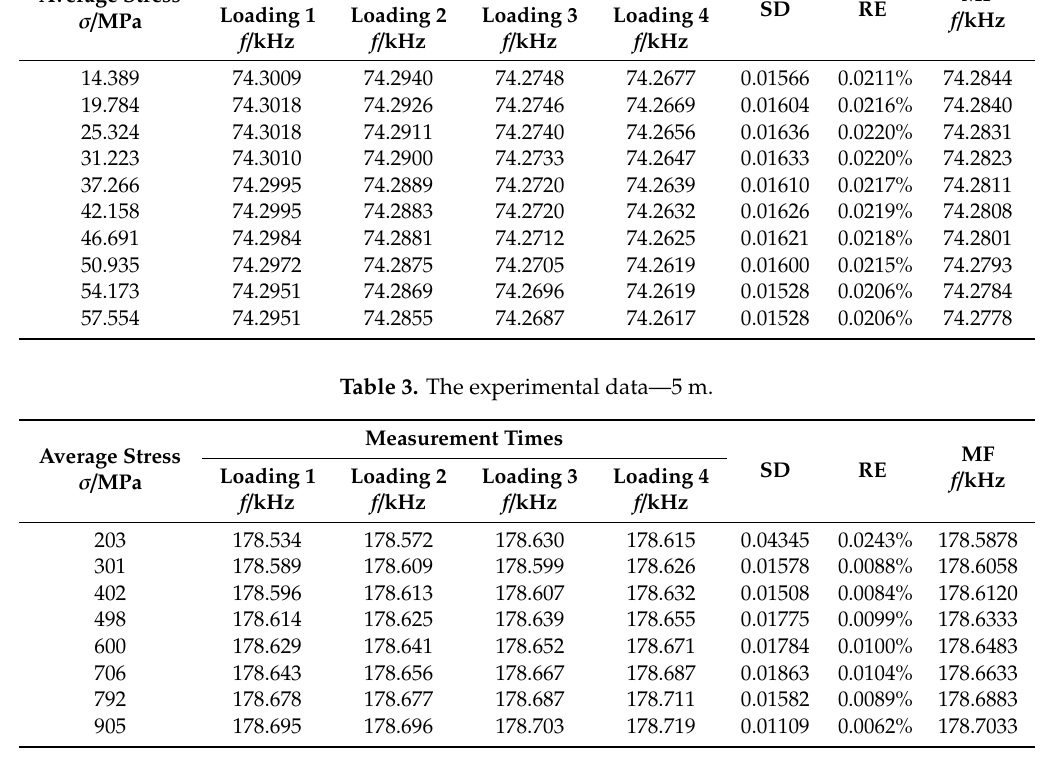
Table 4. The experimental data—10 m.